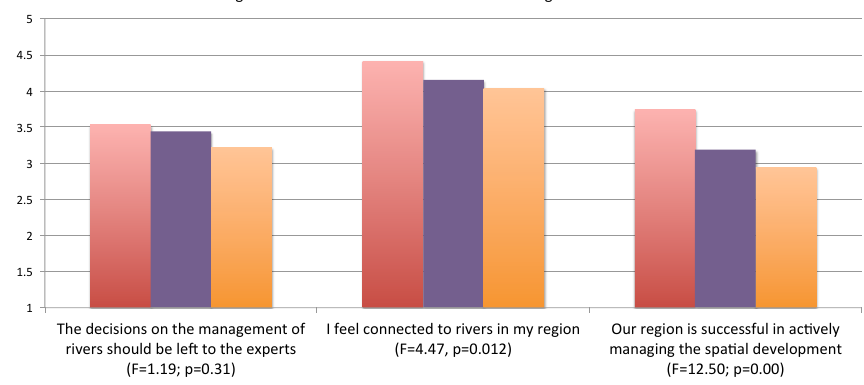
Fig. 2. Swiss inhabitants’ agreement with statements related to their or their region’s motivational capacities, differentiated between groups with and without reported stakeholder involvement in their region. Comparison of mean values (ANOVA). N = 230.